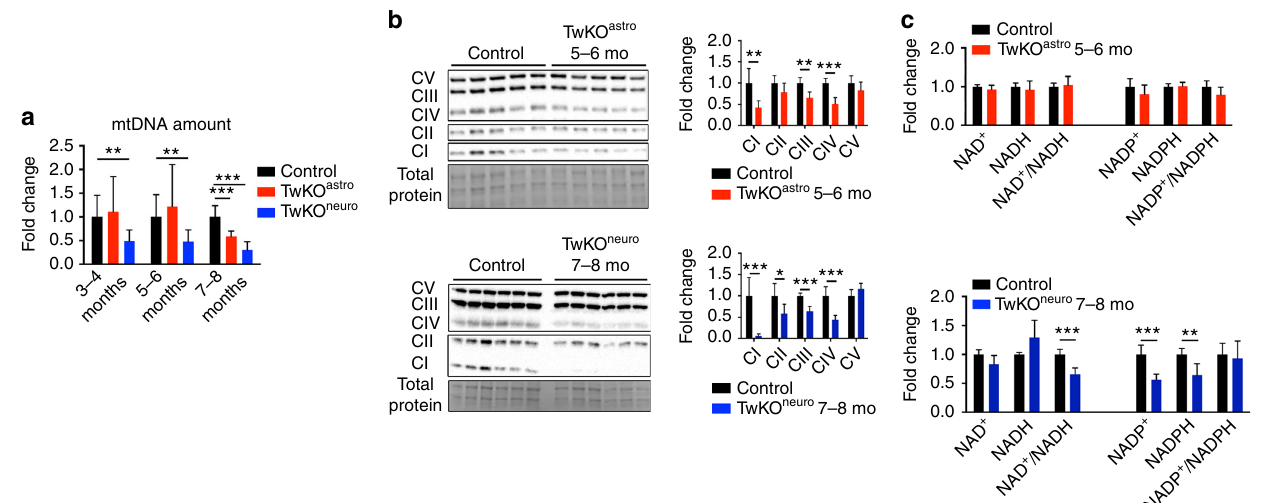
Fig. 2 Mitochondrial consequences of Twinkle inactivation. a MtDNA amount in different ages in TwKO mice. b Western blot of OXPHOS complexes CI – CV and quanti fi cation of signals normalized to total protein. c NAD + , NADH, NADP + , NADPH amounts and their ratios in cortex lysates. The data are presented as mean and error bars indicate standard deviation. Statistical signi fi cance: * p < 0.05, ** p < 0.01, *** p <